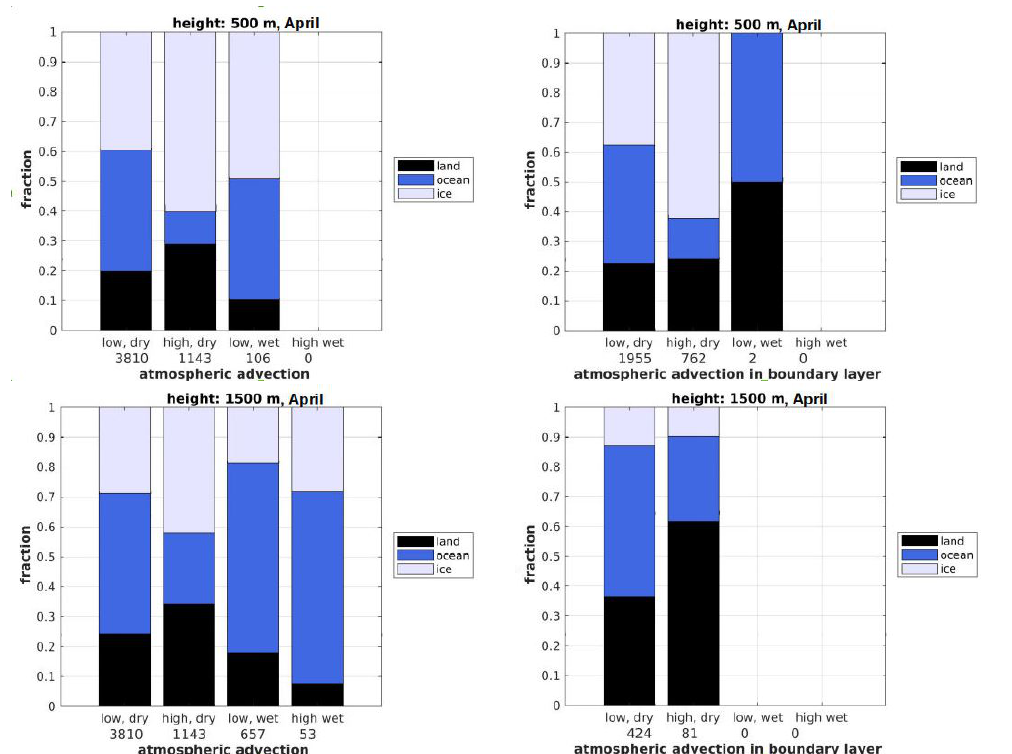
Figure 13. Fraction of how long the air parcel was over land, ocean, or ice. Left: All data points are plotted, independent of the height of the air parcel. Right: Only the cases are plotted where the air parcel was within the boundary layer (defined as p > 900 hPa). This plot only shows the data for the arriving heights of 500 m and 1500 m above Zeppelin Station for all Aprils, 2013–2016. The numbers below the bars indicate the total number of points for each